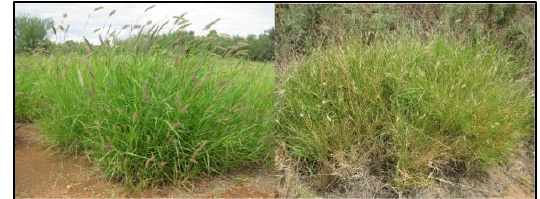
Figure 1: LEFT Juvenile plant growing in creek line; RIGHT mature plant growing at roadside (Photographs by Victoria Marshall, northern South Australia)